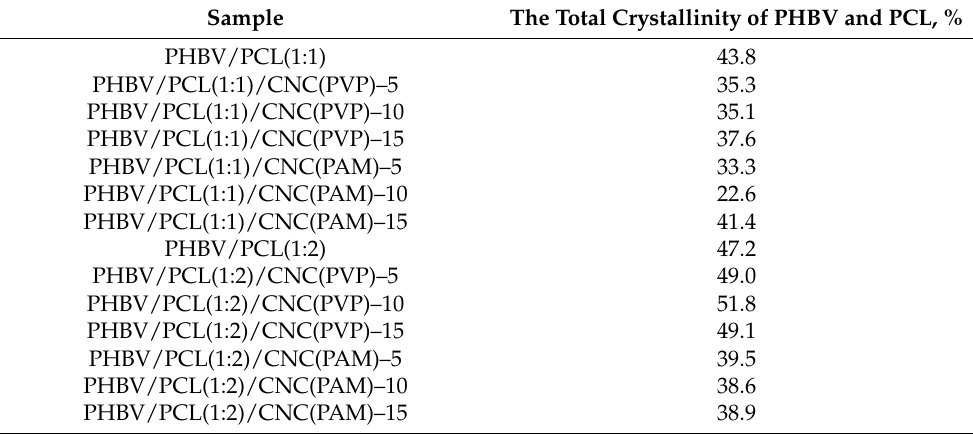
Table 4. The total crystallinity of PHBV and PCL polymers in the composites with CNCs.